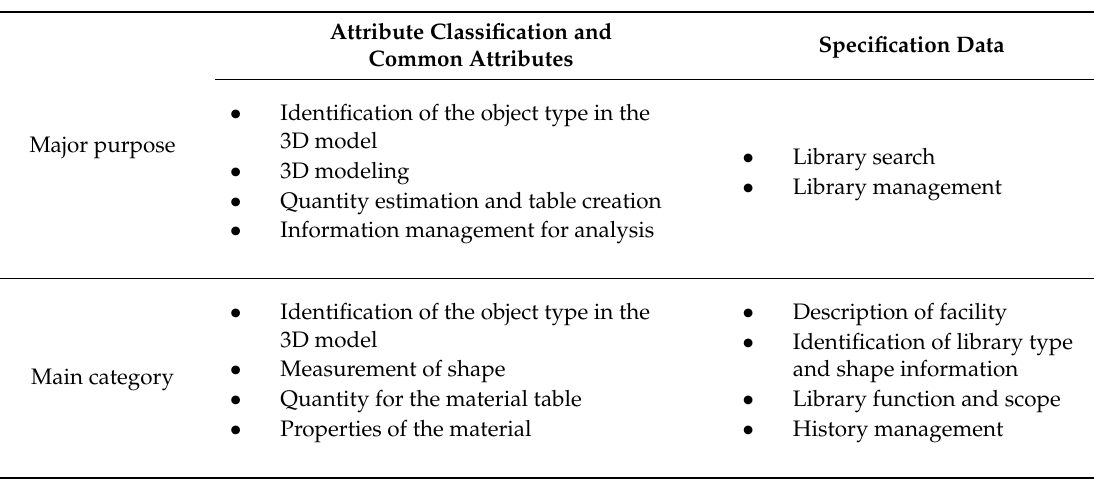
Table 3. Library attribute and specification